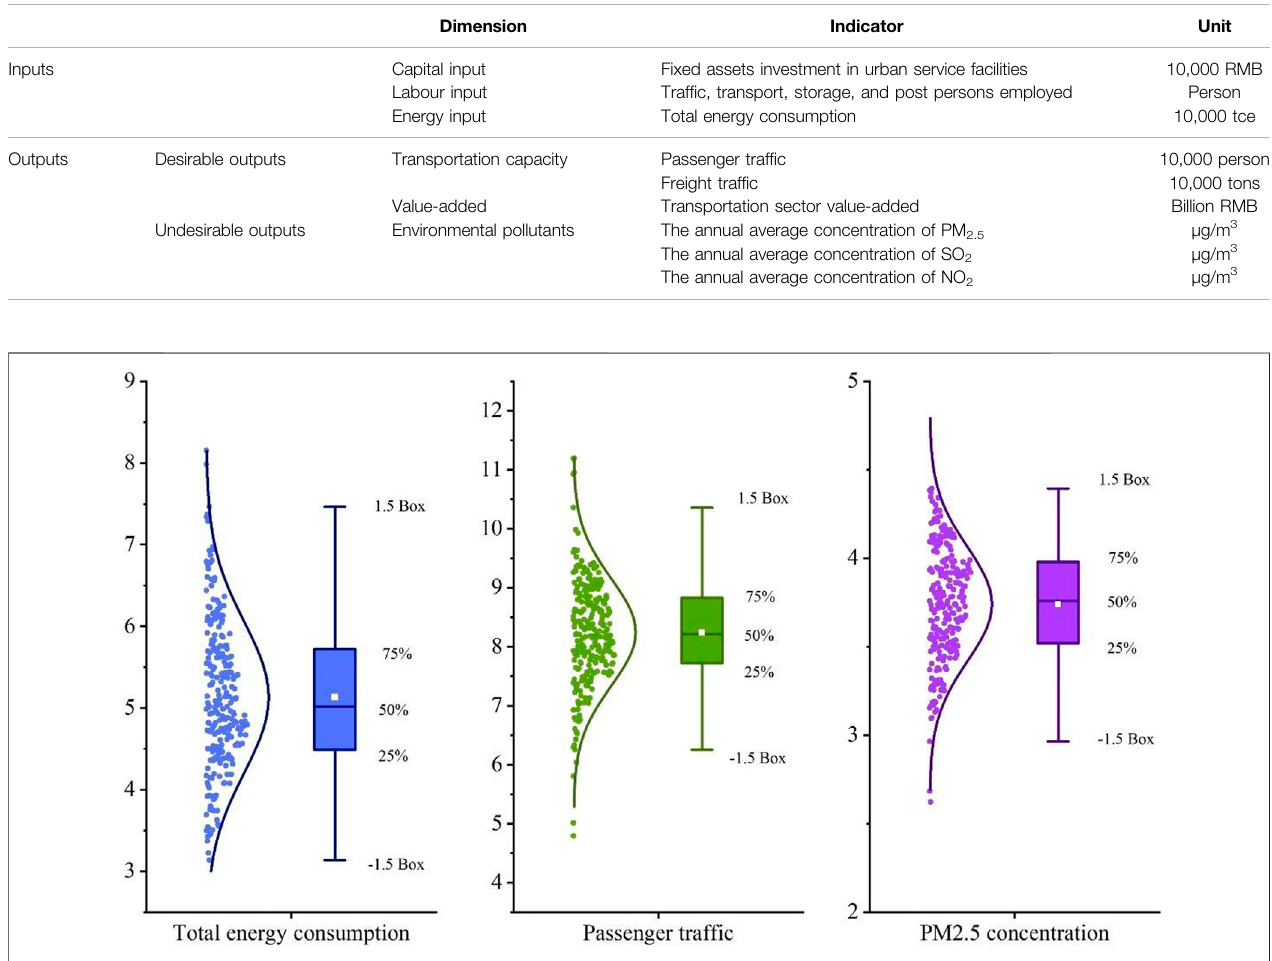
FIGURE 3 | Scatter plots and box charts of the logarithms of the total energy consumption, Passenger traf fi c and PM 2.5 concentration from 2015 to 2019 in the 255 Chinese cities.